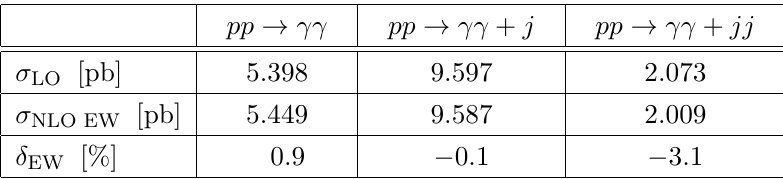
Table 1 . Total cross sections at LO and NLO for (cid:13)(cid:13) +0 ; 1 ; 2 jets production at 13 TeV at the